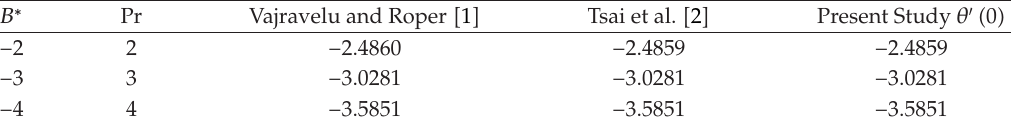
Table 1: Comparison of θ (cid:5) (cid:5) 0 (cid:6) for various values of Pr and B ∗ when β (cid:8) 0, Gr (cid:8) 0, A ∗ (cid:8) 0, Q (cid:8) 0, Ec (cid:8) 0, and N (cid:8) 0.